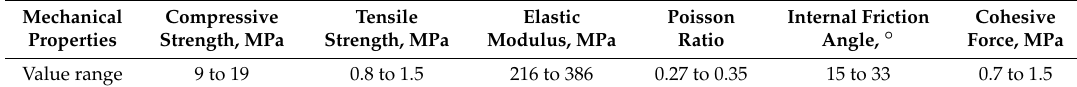
Table 7. Mechanical properties of the oil shale in Huadian [26].